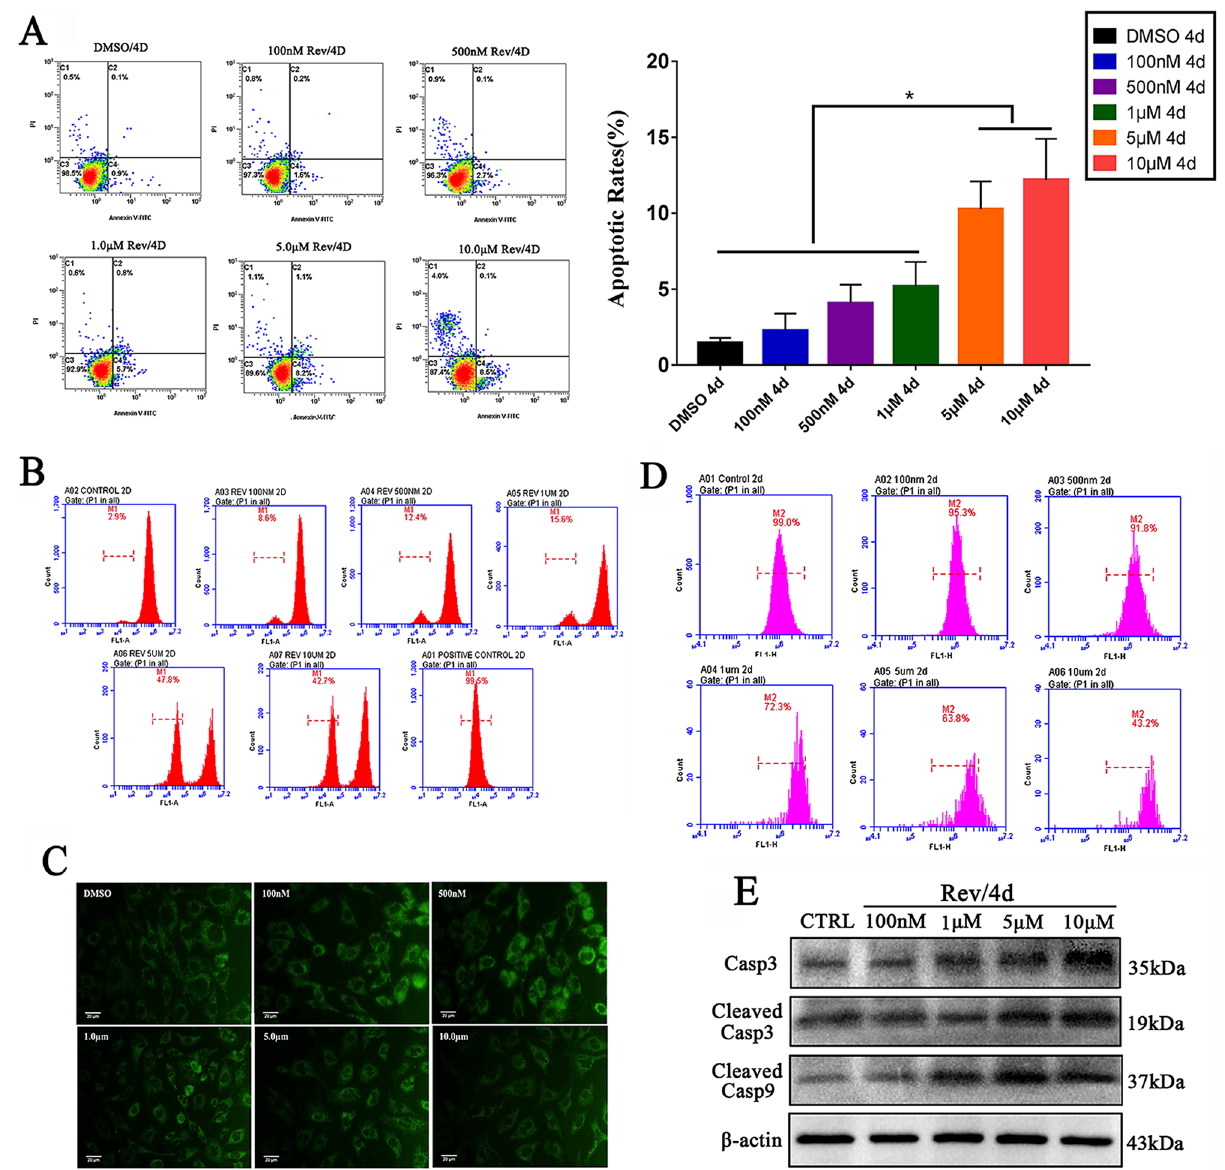
Figure 4. Rerversine provokes ROS accumulation and mitochondrial dysfunction in fibroblasts. ( A ) Cell apoptosis was detected in the reversine treatment groups and the DC group using Annexin V-FITC/PI and flow cytometry. ( B ) Intracellular ROS levels were detected using DCFH-DA by flow cytometry. ( C ) Rh123 fluorescence photomicrographs were observed under an inverted fluorescence microscope. ( D ) MMP was determined using rhodamine 123 by flow cytometry. ( e ) Relative protein expression levels of cell apoptosis related genes were detected by Western The high-throughput RNA sequencing for mRNA expression discrepancies. Approximate 24.0 Gb of clean reads were acquired from the 4 libraries, and 23,033 unigenes were identified by comparing the genome of Ovis aries . By the clustering analysis, R1 and R4 aggregated at one branch, C1 and D15 aggregated at one branch (Fig. 8A). Similarly, R1 possessed the similar expression profile to R4, while C1 was similar with D15 via principal component analysis (PCA) (Fig. 8B) and correlation heat map (Fig. 8C). And, after 15 days of reversine removal, the induced fibroblasts gradually returned to similar phenotype with original control cells. Therefore, it could be shown that sheep fibroblasts were highly sensitive to reversine, which was attributed to its susceptibility and plasticity. A mass of differentially expressed genes (DEGs) were detected by RNA-Seq, comprising 1,454 genes between R1 and DC, 319 genes between R4 and DC, 351 genes between D15 and DC. The most important 27 DEGs were found among four groups (Fig. 8D). To determine their common molecular and cellular functions, these 27 genes were analyzed by IPA analysis and attributed these functions: DNA Replication, cellular growth and proliferation and cell-to-cell signaling and interaction (Fig. 8E). To demystify the molecular mechanism of fibroblast cells